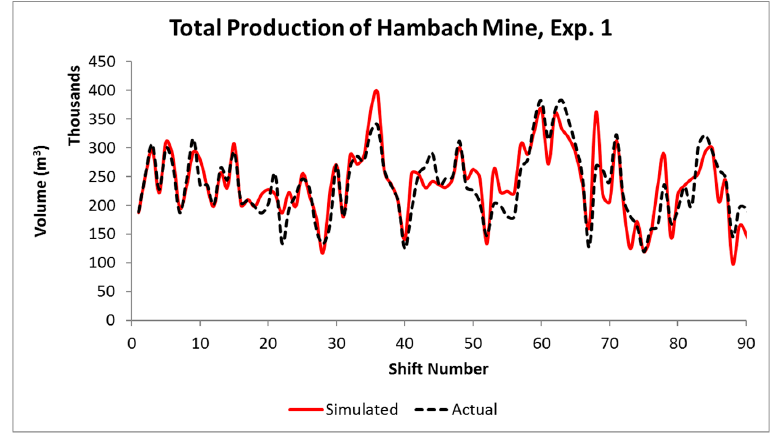
Figure 19. The total shift-based production of the Hambach mine, Experiment 1.